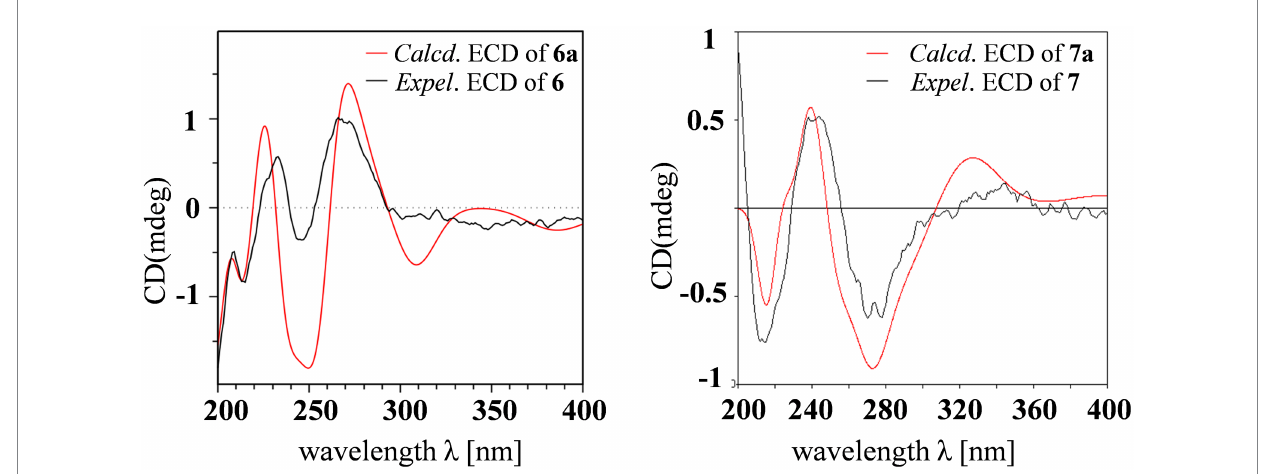
FIGURE 7 Experimental ECD spectra of 6 and 7 and calculated ECD spectra of 6a and 7a .